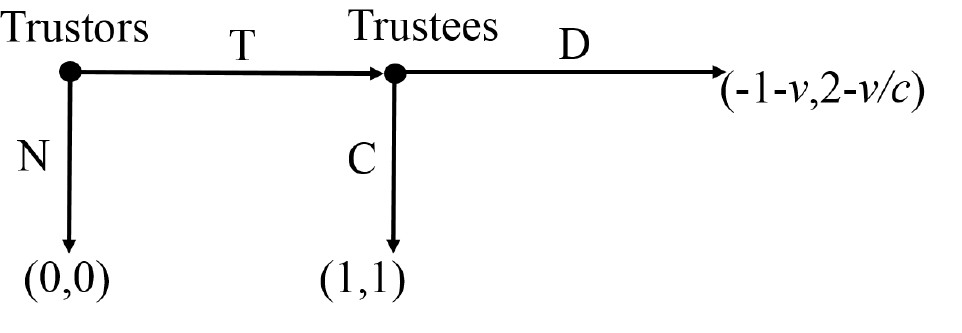
Figure 1. Trust Game in Extensive